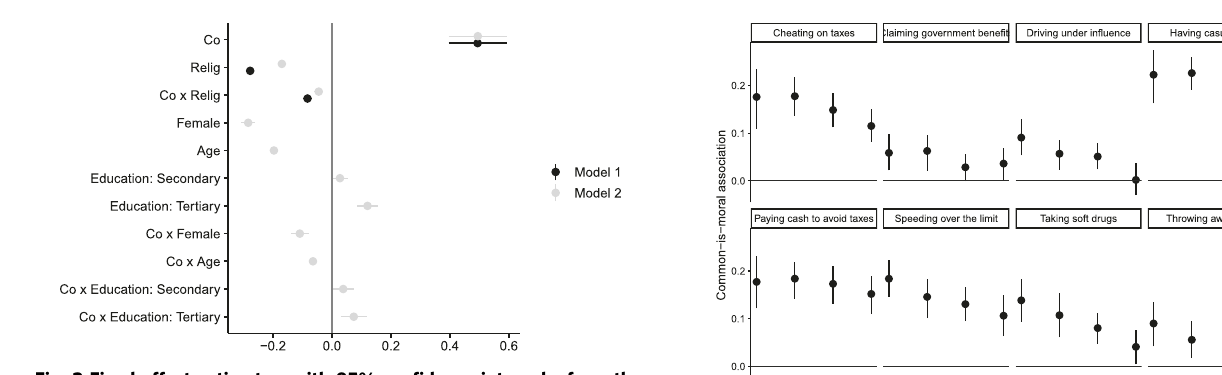
Fig. 3 Fixed effect estimates, with 95% con fi dence intervals, from the three-level model of moral judgements with Co centred at the individual mean and the rest of the predictors centred at the country means. Model 1 (black) shows unadjusted coef fi cients of interest. Model 2 (grey) additionally include control variables.